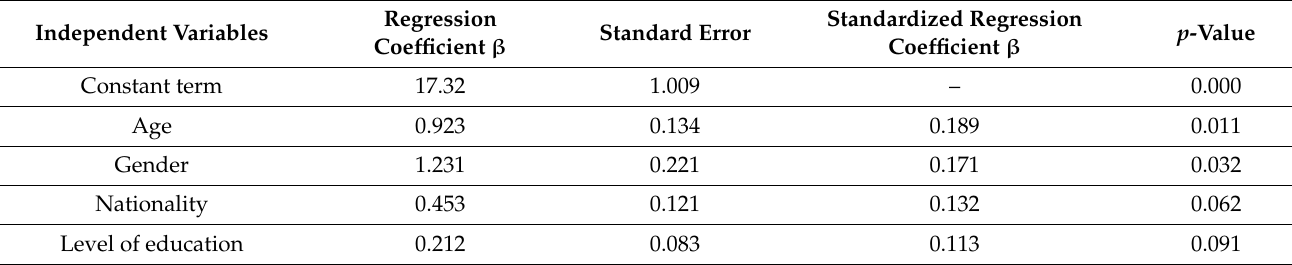
Table 8. Multiple stepwise linear regression analysis of factors influencing KAP